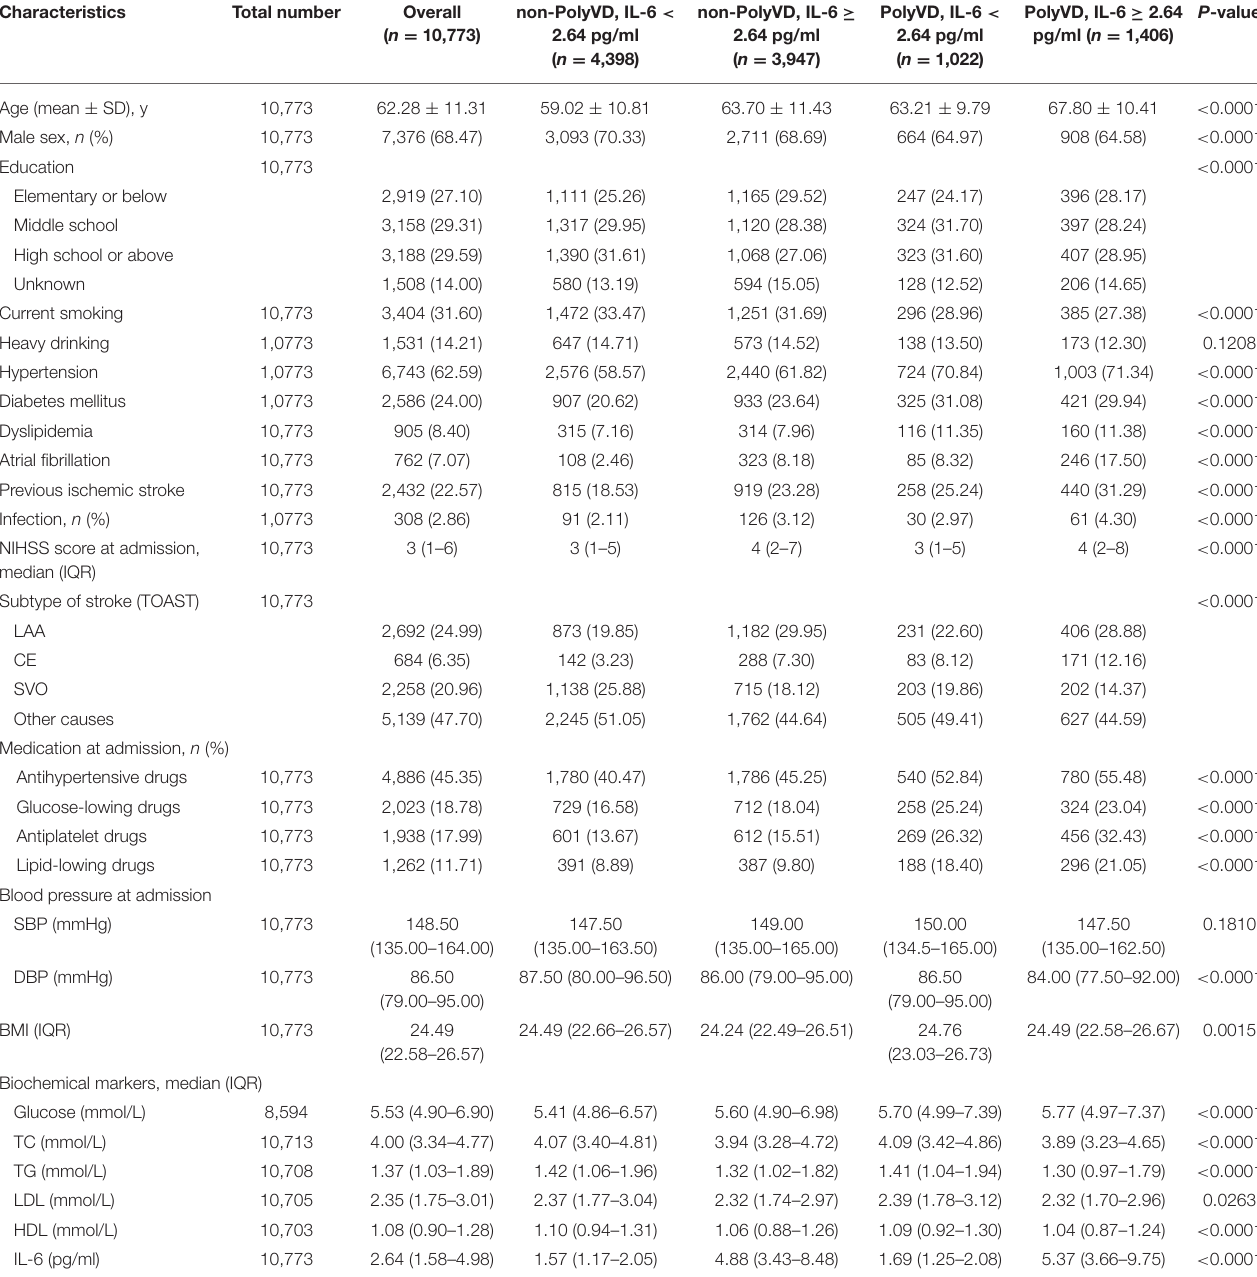
TABLE 1 | Baseline characteristics of patients according to atherosclerosis vascular beds involvement numbers and IL-6 level.